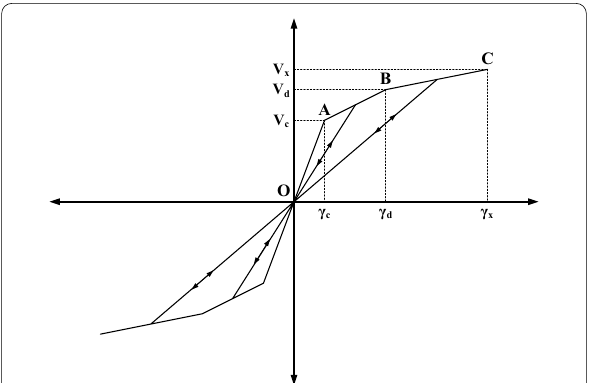
Fig. 6 Proposed hysteric curve for nonlinear section